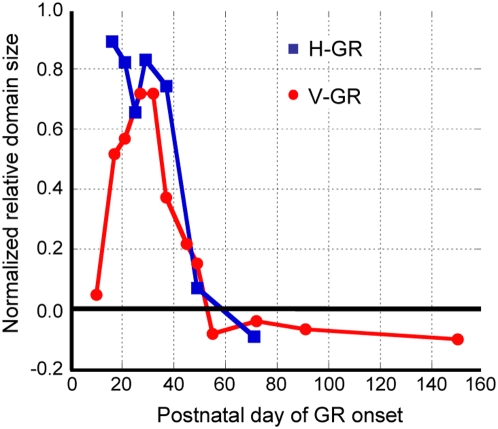
Sensitivity profiles for orientation plasticity.Ordinate: orientation sensitivity defined by (x-y)/(1-y), where x represents the relative size of cortical domains for the exposed orientation in a goggle-reared kitten, and y represents the value of the smoothed curves for normal kittens (Fig. 1g) for the same orientation. Red dots: vertical orientation; blue squares: horizontal orientation. Abscissa: postnatal day of 2-week GR onset.